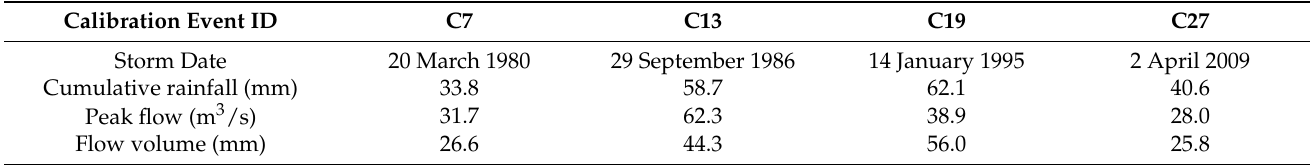
Table 1. Selected calibration storm events.